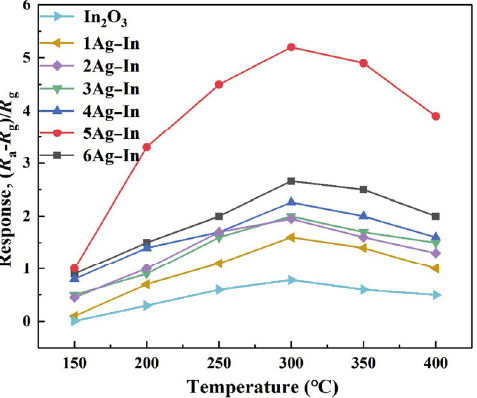
Fig. 8 Sensor responses of seven Ag–In 2 O 3 gas sensors towards 5 ppm isopropanol at 150–400 .